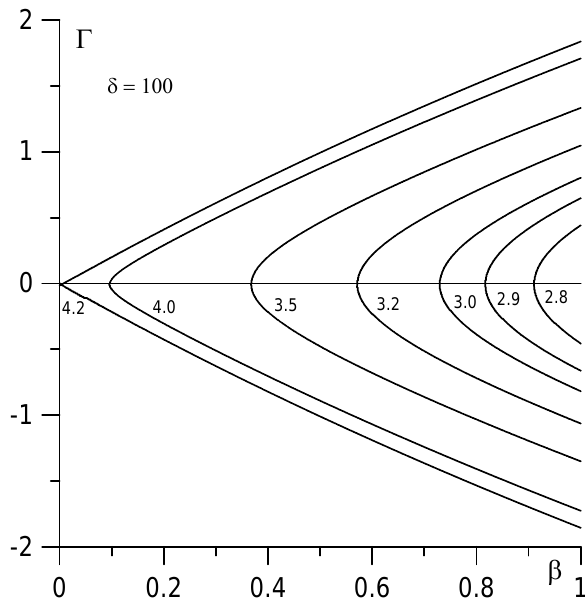
Fig. 5e. The same for δ = 100 (local midnight). Figure 5e. The same for (local midnight). 100 =δ